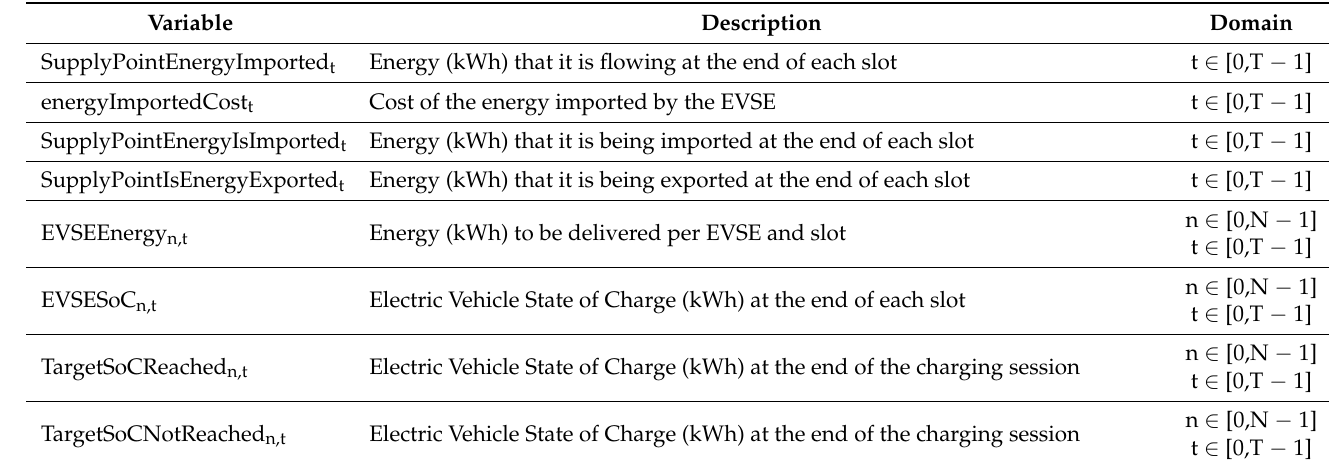
Table 2. Intermediary variables for the objective function for optimum charging